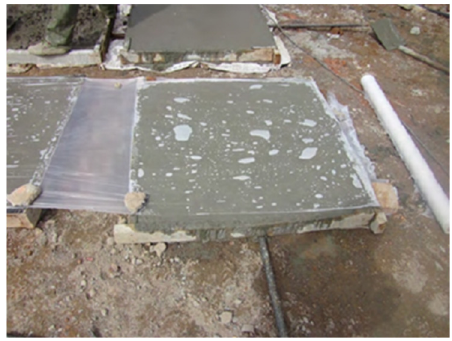
Figure 1. The scene picture of the anchor-plate.